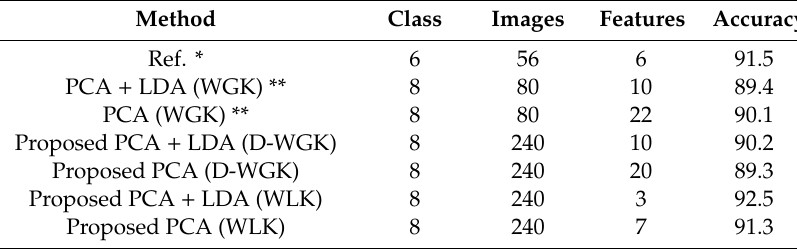
Table 1. The comparison between the presented methods.